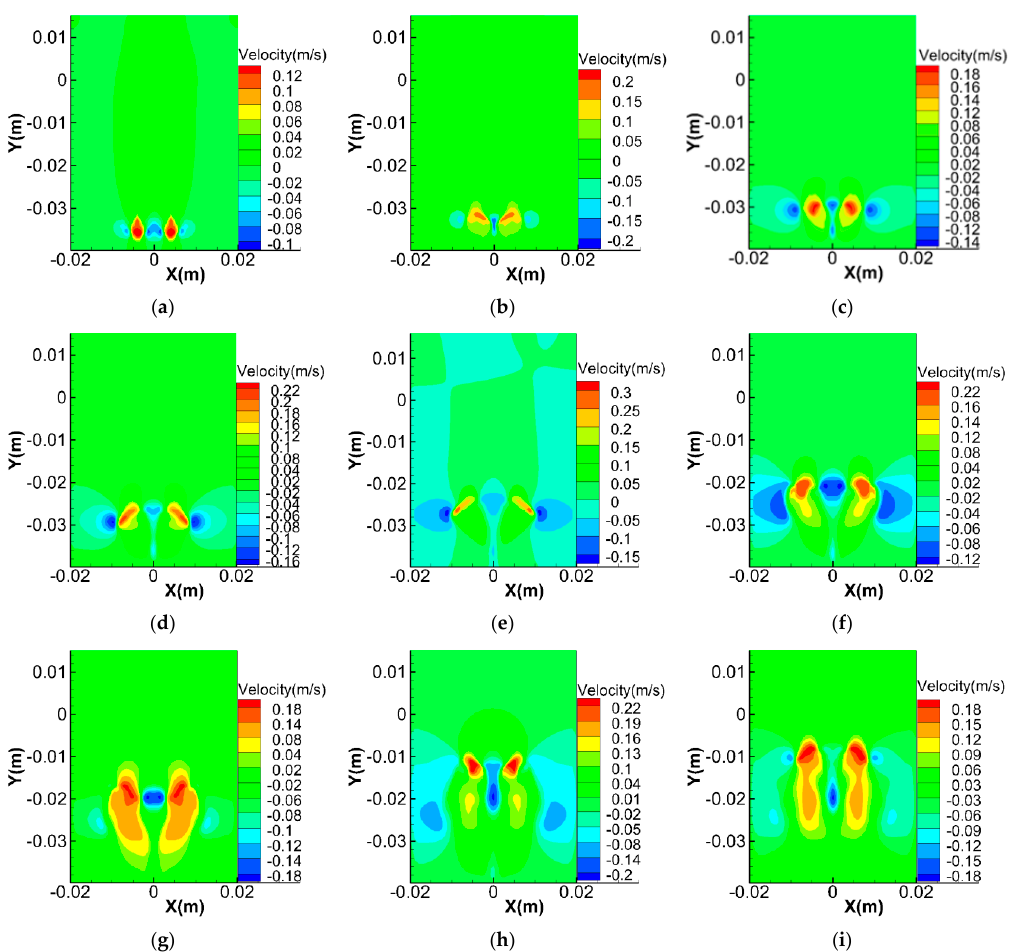
Figure 15. The velocity distribution of two rising bubbles. ( a ) t = 0.01 s; ( b ) t = 0.04 s; ( c ) t = 0.06 s; ( d ) t = 0.08 s; ( e ) t = 0.1 s; ( f ) t = 0.13 s; ( g ) t = 0.15 s; ( h ) t = 0.20 s; ( i ) t = 0.22 s.